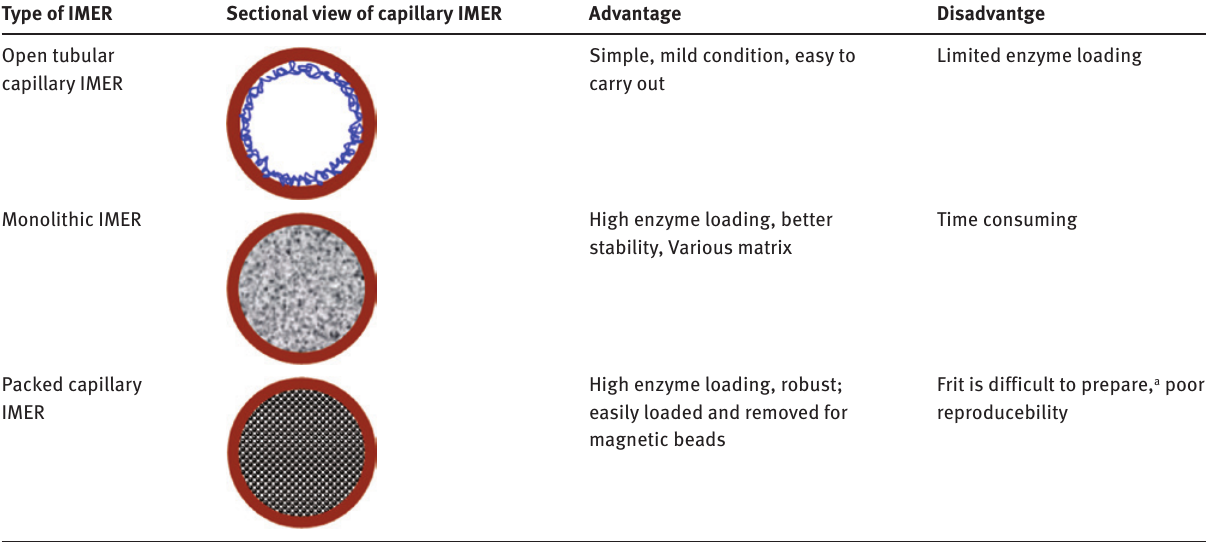
Table 1: Advantage and disadvantages of the three categories of CE-integrated IMERs.